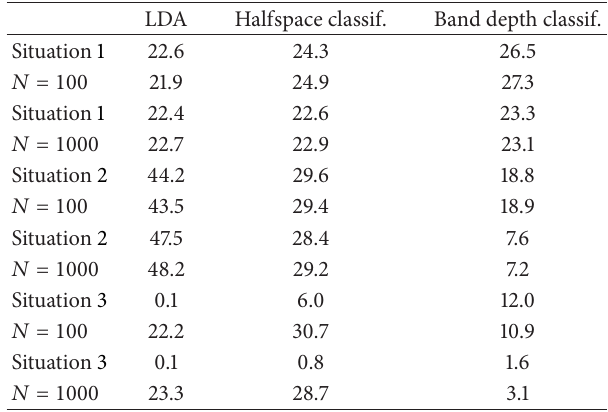
Table 1: Simulated situations. Table 2: Mean misclassification rates (in percent) for population 1 (upper) and population 2